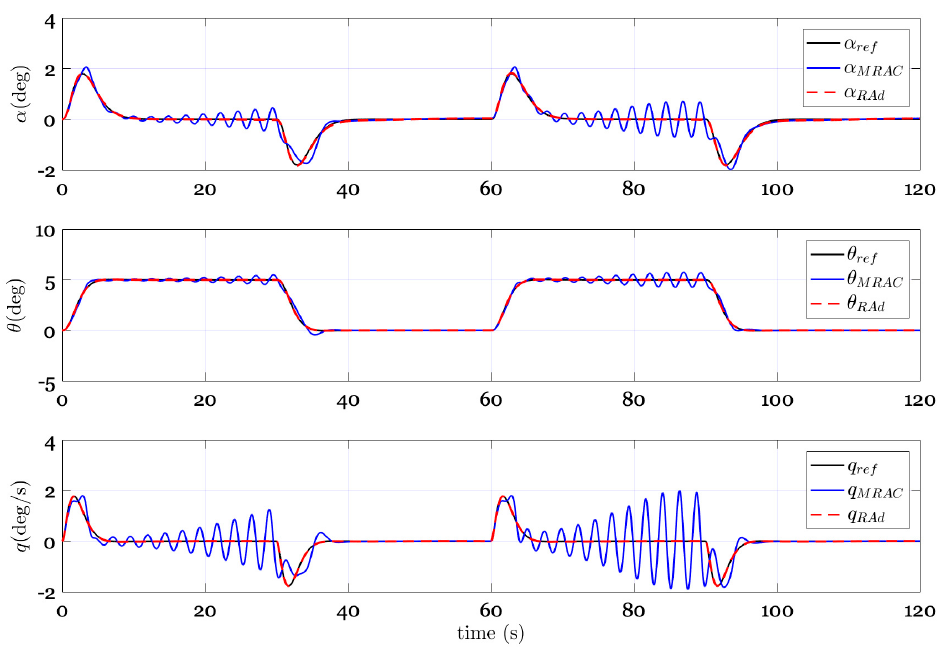
Figure 2. Aircraft response for MRAC and robust adaptive controller with ρ λ = ρ θ = 0.01.